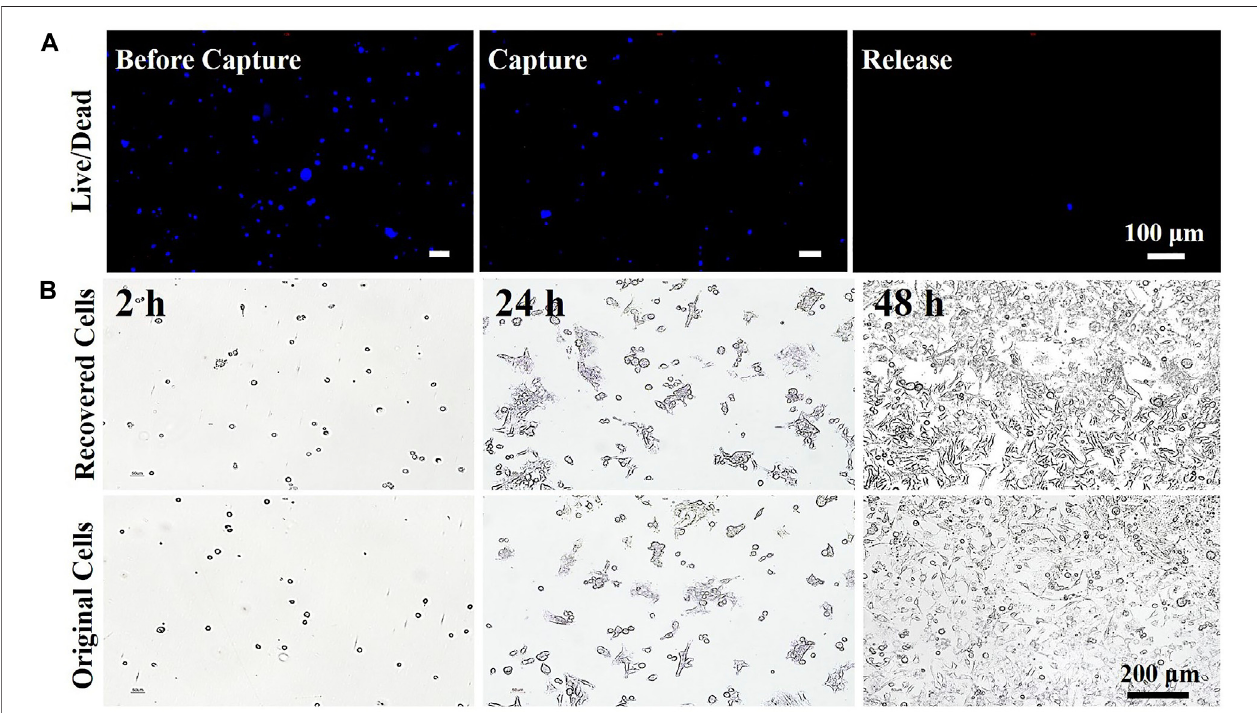
FIGURE8| Microscopeimageof4T1cellsafterthreecyclesofcaptureandrelease. (A) Live/deadcell-stainingimagesand (B) celladhesivestatusandproliferation pro fi les of the original and recovered 4T1 cells over 3 days.